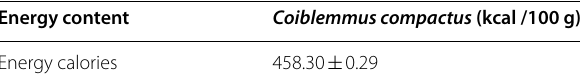
Table 4 Energy contents of Coiblemmus